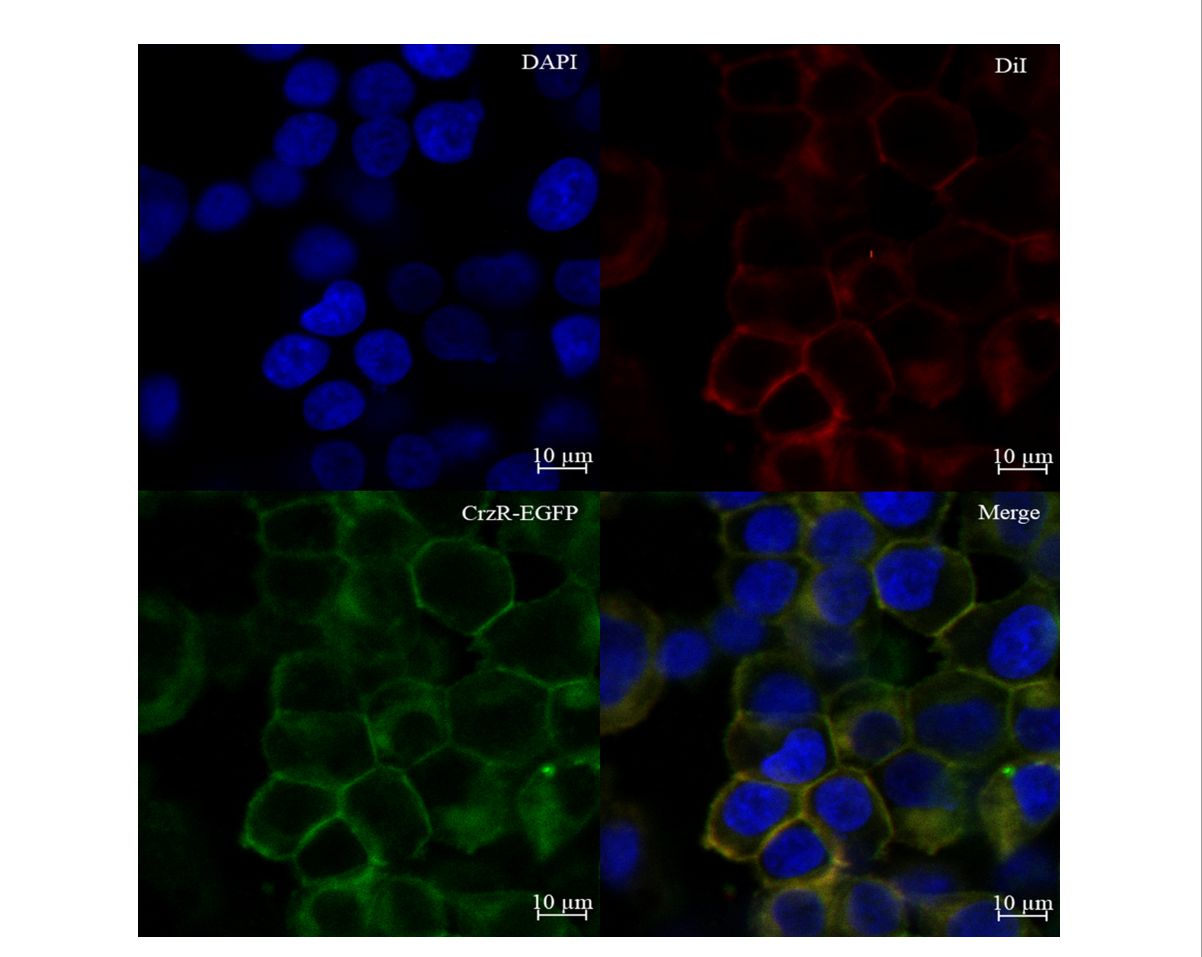
FIGURE 1 Expression of PtCrzR in HEK293T cells. Cells expressing Pt CrzR/pEGFP-N1 fusion protein were stained with a nuclei probe (DAPI) and a membrane plasma probe